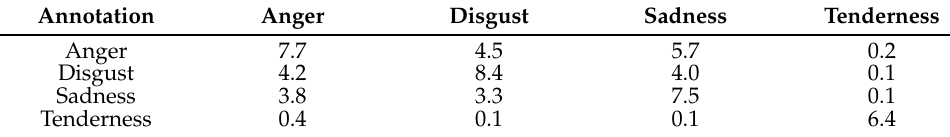
Table 5. Emotion ratings for each subjective emotion annotation